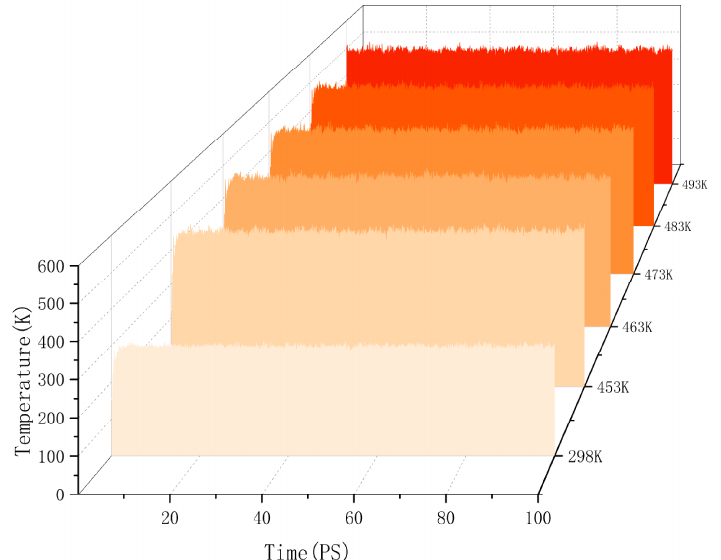
Figure 2. Temperature fl uctuation.